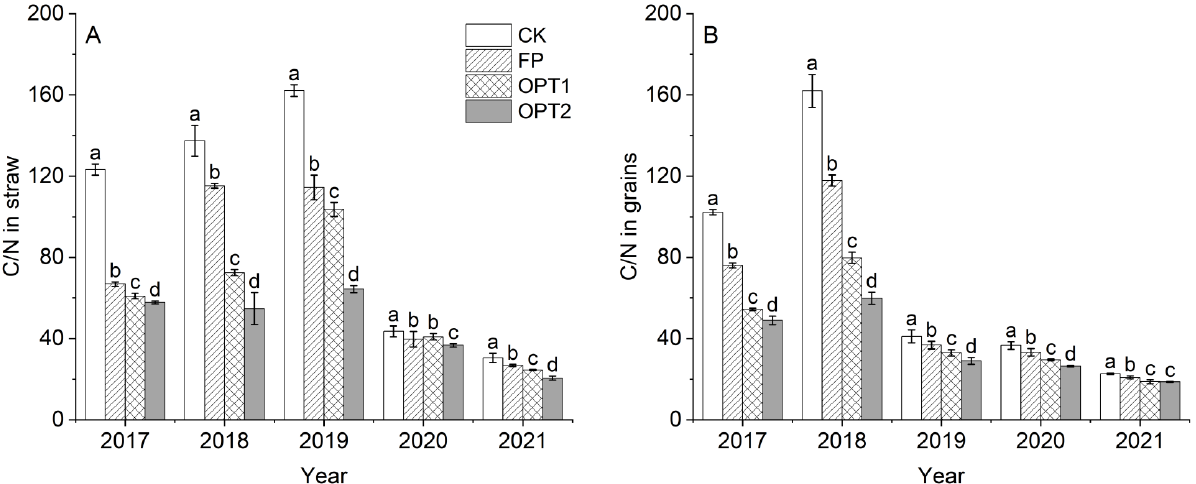
Figure 6. C/N in straw (C/N S ) ( A ) and C/N in grains (C/N G ) ( B ) of the plants under four management systems. Means followed by the same letter do not significantly differ (LSD, p < 0.05).